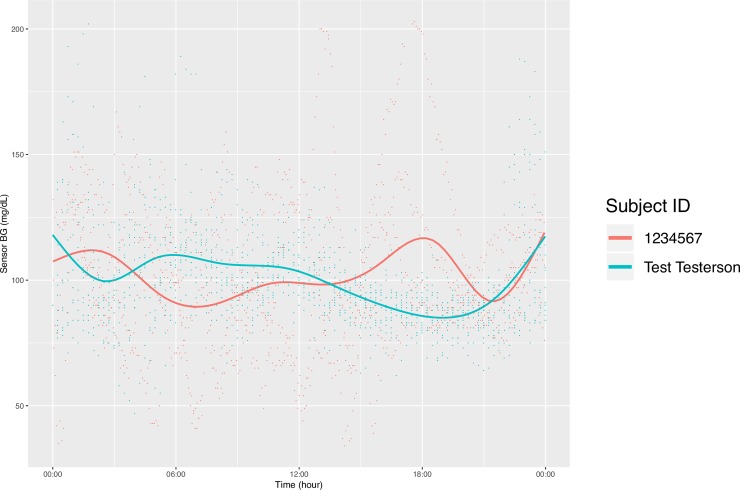
Daily Overlay per Subject (LOESS Smoothing).